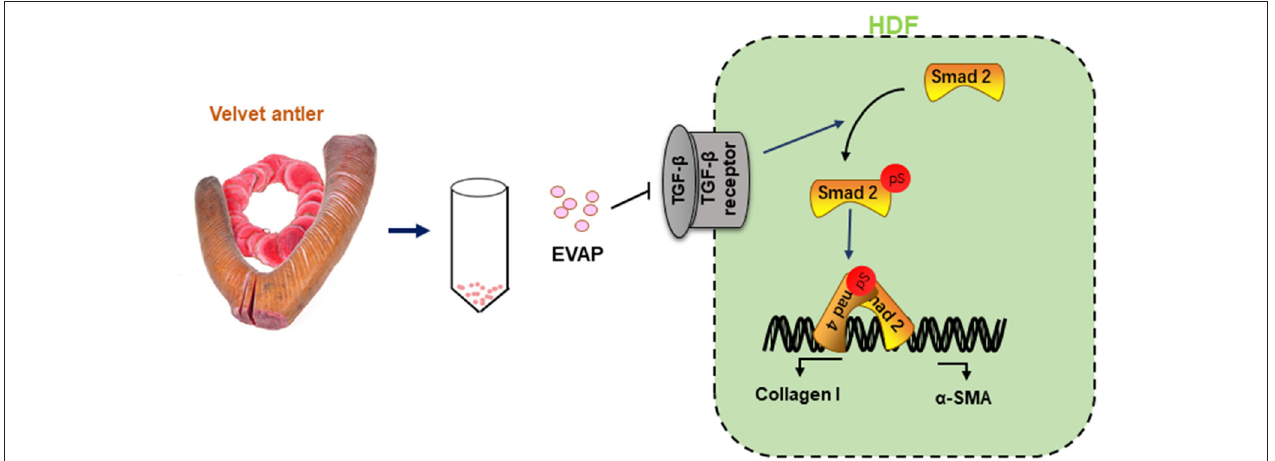
FIGURE 8 | Reduction of scar formation with the treatment of EVAP may be through inhibiting the TGF- β signaling pathway. After wounding, expression level of TGF- β 1 rises rapidly, which phosphorylates Smad2 to initiate the TGF- β 1 signaling pathway. Activated TGF- β 1 pathway stimulates the transdifferentiation of HDFs to myofibroblasts. Continuous myofibroblast transdifferentiation causes excessive collagen production and thus scar formation, and was effectively reduced through inhibition of the TGF- β signaling pathway and thus transdifferentiation of myofibroblasts with EVAP application.